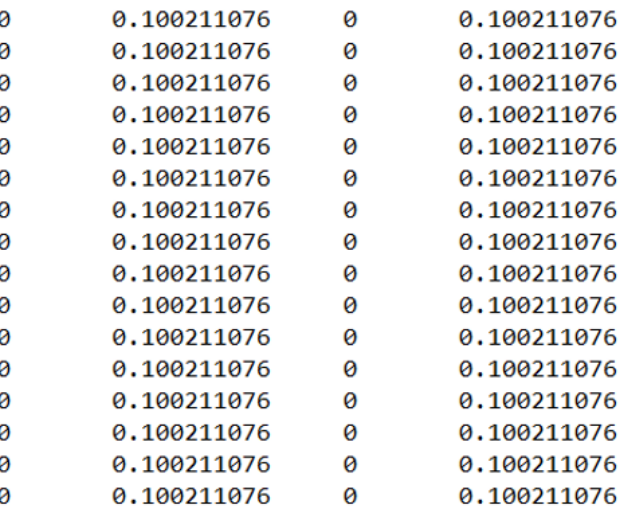
Figure 8. Data set values for the training of the fuzzy neural network.